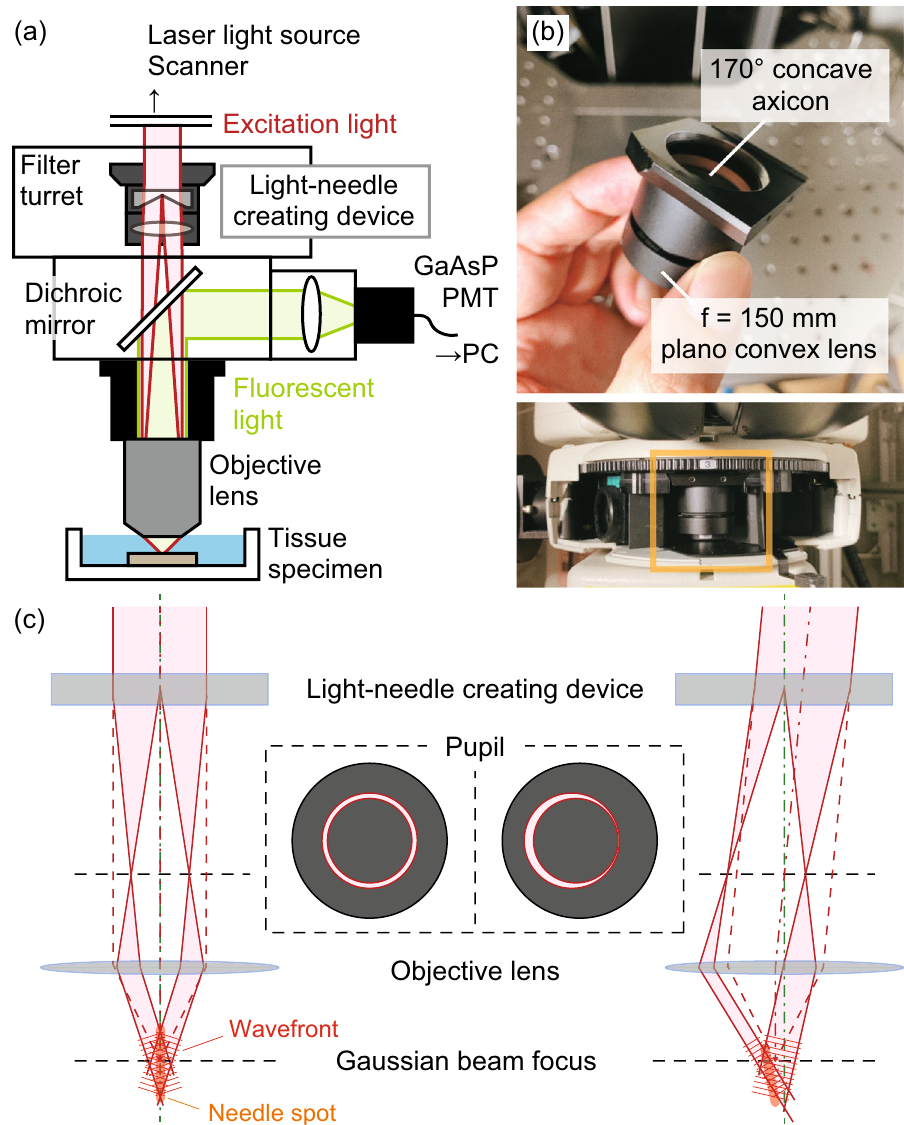
Figure 1. ( a ) Optical schematic of the developed light-needle microscopy. ( b ) Photograph of a light-needle creating device placed in a filter turret of an upright microscope. ( c ) Schematic of the generation of a light- needle spot for the nominal incidence (left) and the oblique incidence (right) to the device, under raster- scanning of an excitation laser light